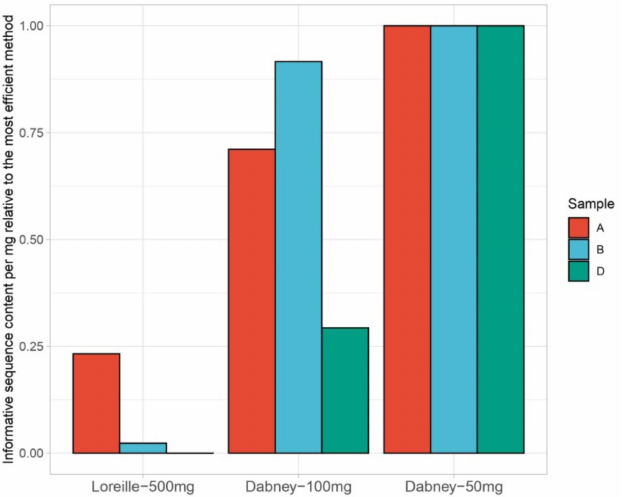
Figure 3. Informative sequence content normalized to the most efficient method (Dabney-50 mg) for samples A, B, and D considering only Lor-500 mg, Dab-100 mg, and Dab-50 mg methods (for sample B, the mean of all earlier extraction trials with 50 mg was calculated). All results were normalized according to the amount of bone powder input